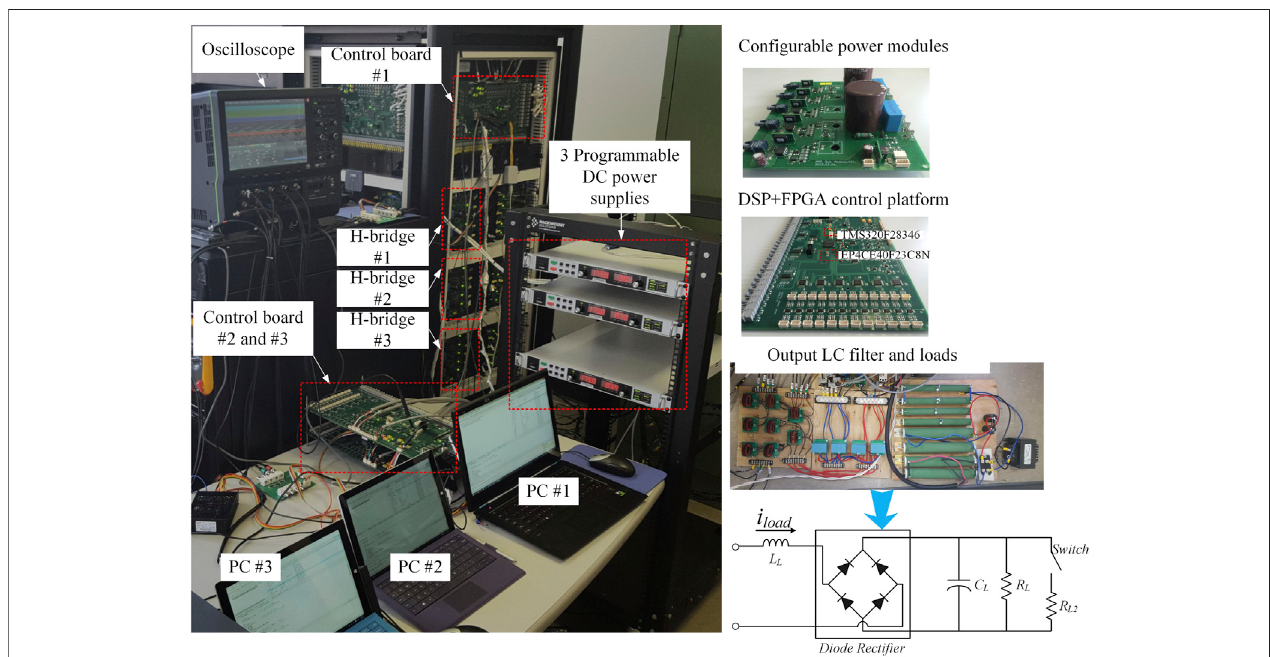
FIGURE 12 | Experimental setup.